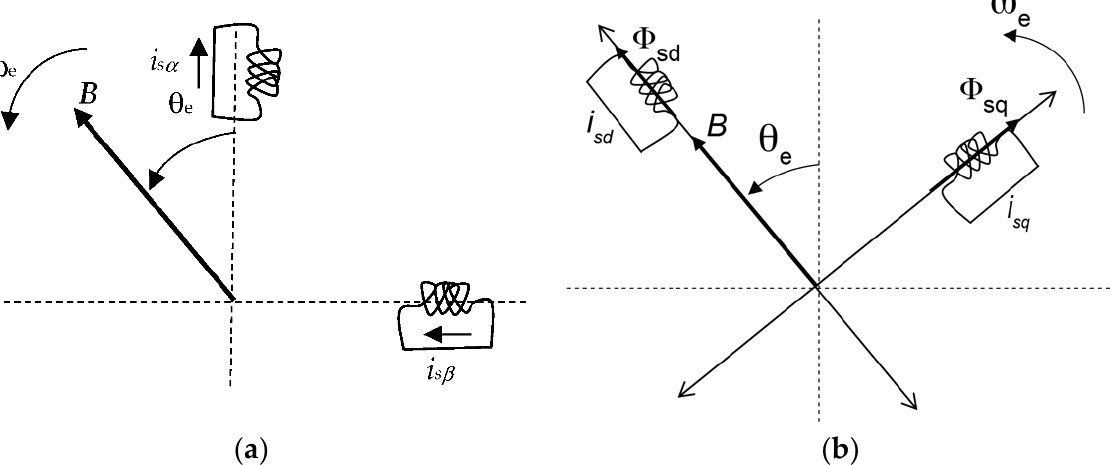
Figure 4. The reference systems that simplify the equations of the magnetic induction in the AC motor model: ( a ) αβ or stationary ; ( b ) qd or rotative .